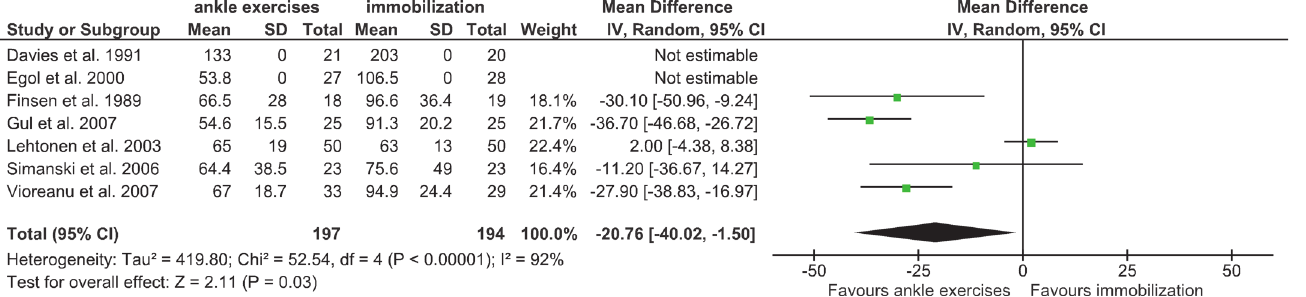
Fig 3. Effect of mobilization; return to work/daily activities. The mean difference (SD) on the return to work/daily activities is shown between the ankle exercises groups and the immobilization groups.